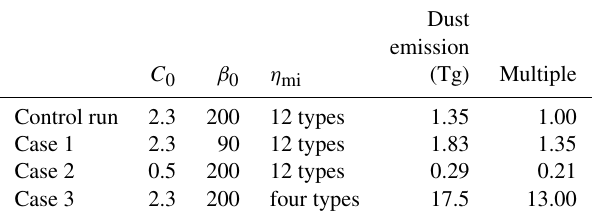
Table B3. Sensitivity of the simulated total dust emission from the Shao2011 to model parameters over the 7d simulation period 1– 7 May 2017. The multiple of the dust emission of different cases is calculated with respect to the control